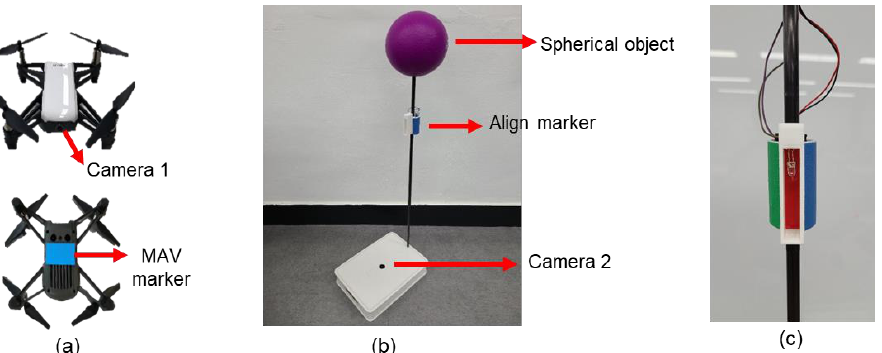
Figure 1. MAV and landing system. ( a ) MAV with camera and bottom marker; ( b ) landing platform with a spherical object, align marker, and camera; ( c ) align marker.